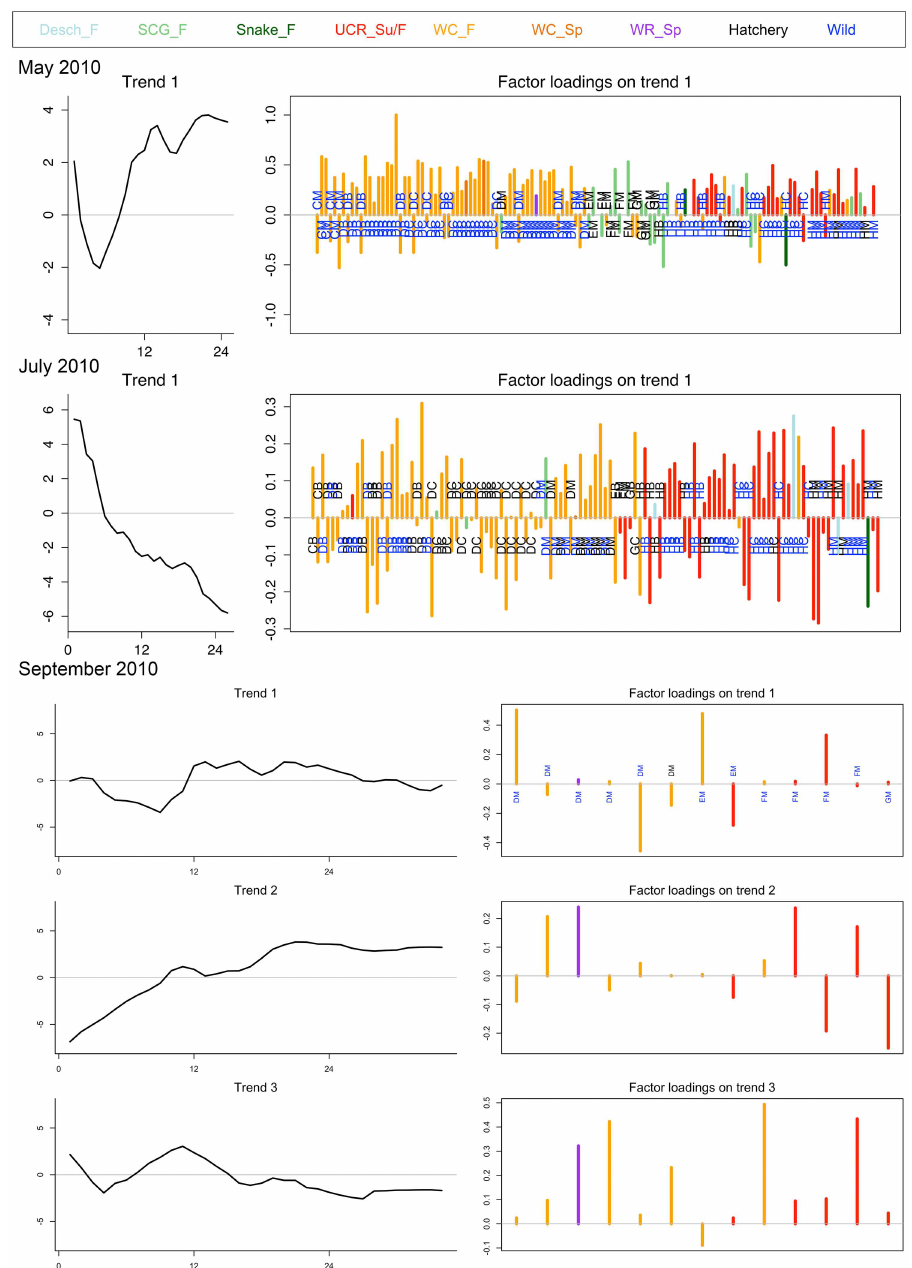
Fig 3. DFA trends(left)and trendloadings(right)for each monthlycapturegroup in 2010. The trends are reported as z-scoredgrowth rates (y-axis)over weeks (x-axis)startingat estimatedemergence and endingat capturein the estuary. The trendloadings show each individualfish’s relationshipto that trend(e.g. positive or negative) by capturelocation(site acronyms listed).The trendloadingsalso denote geneticstock of originfor each individual(barcolor)and hatcheryor wild origin(siteacronym